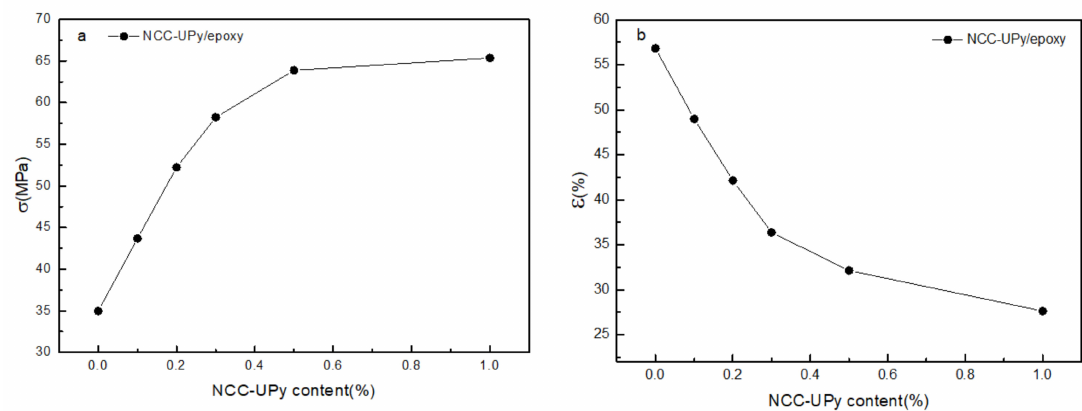
Figure 12. ( a ) Tensile strength and ( b ) elongation at break curves of NCC-UPy/epoxy composite films as a function of the cellulose